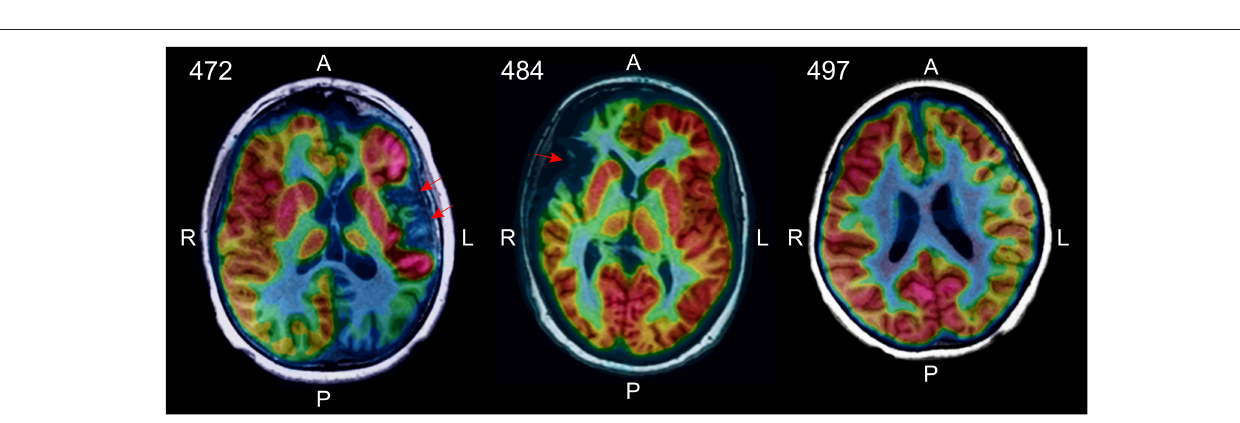
CD16, however populations of CD56 dim NK cells expressing little or no CD16 have been previously described (34).